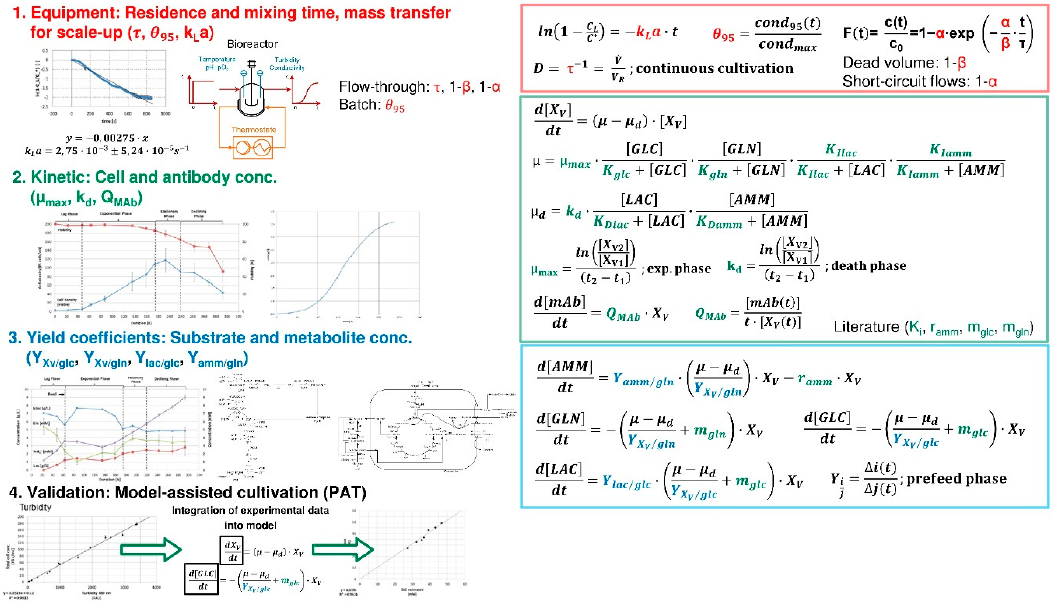
Figure 5. Upstream Processing (USP)—Fermentation Batch/Fed-batch/Perfusion—process modeling workflow, recipe, standard operation procedure